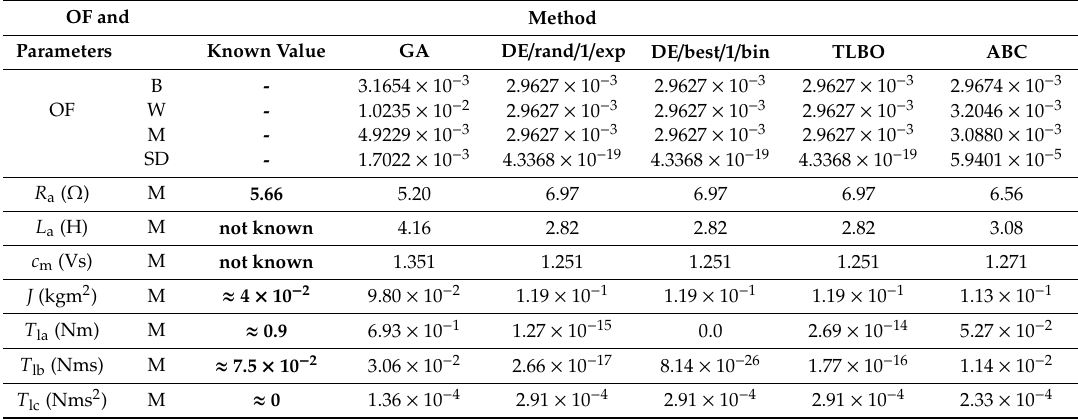
Table 16. OF and Mean value of the calculated parameters for 50 independent runs using RK for MD4. OF and Method